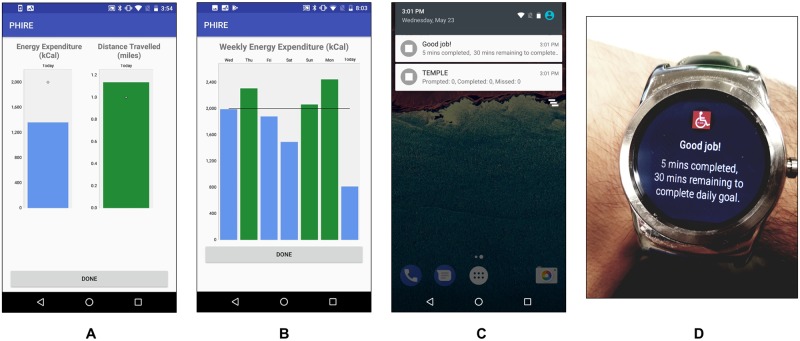
PA Feedback and JITAI provided by PHIRE app.(A) Daily and (B) weekly PA feedback were provided to the participants via the app during the 2nd and 3rd phases of the study. Examples of JITAI messages provided on the (C) smartphone and (D) smartwatch for the 3rd phase of the study.